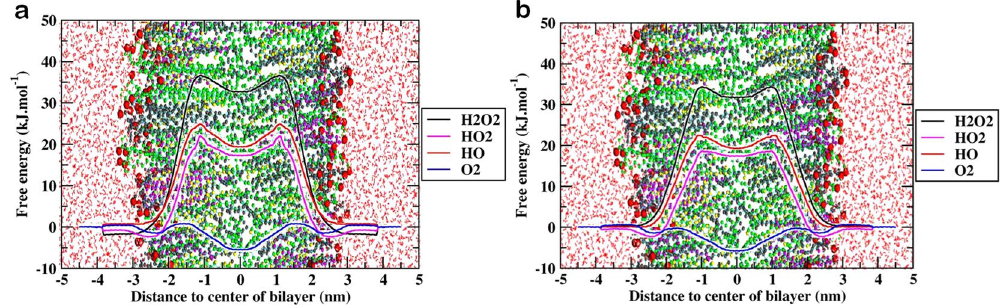
Figure 7. Free energy profile of different reactive oxygen species (ROS) across oxidized skin-lipid bilayer (CER- CHO-FFA-5 α -CH) membrane ( a ) MEMB_12.5; ( b )